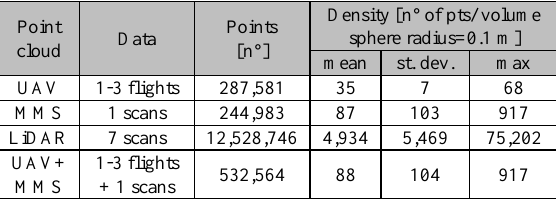
Table 12. Values of the analysis of point clouds density calculated on a sphere of 10 cm radius.